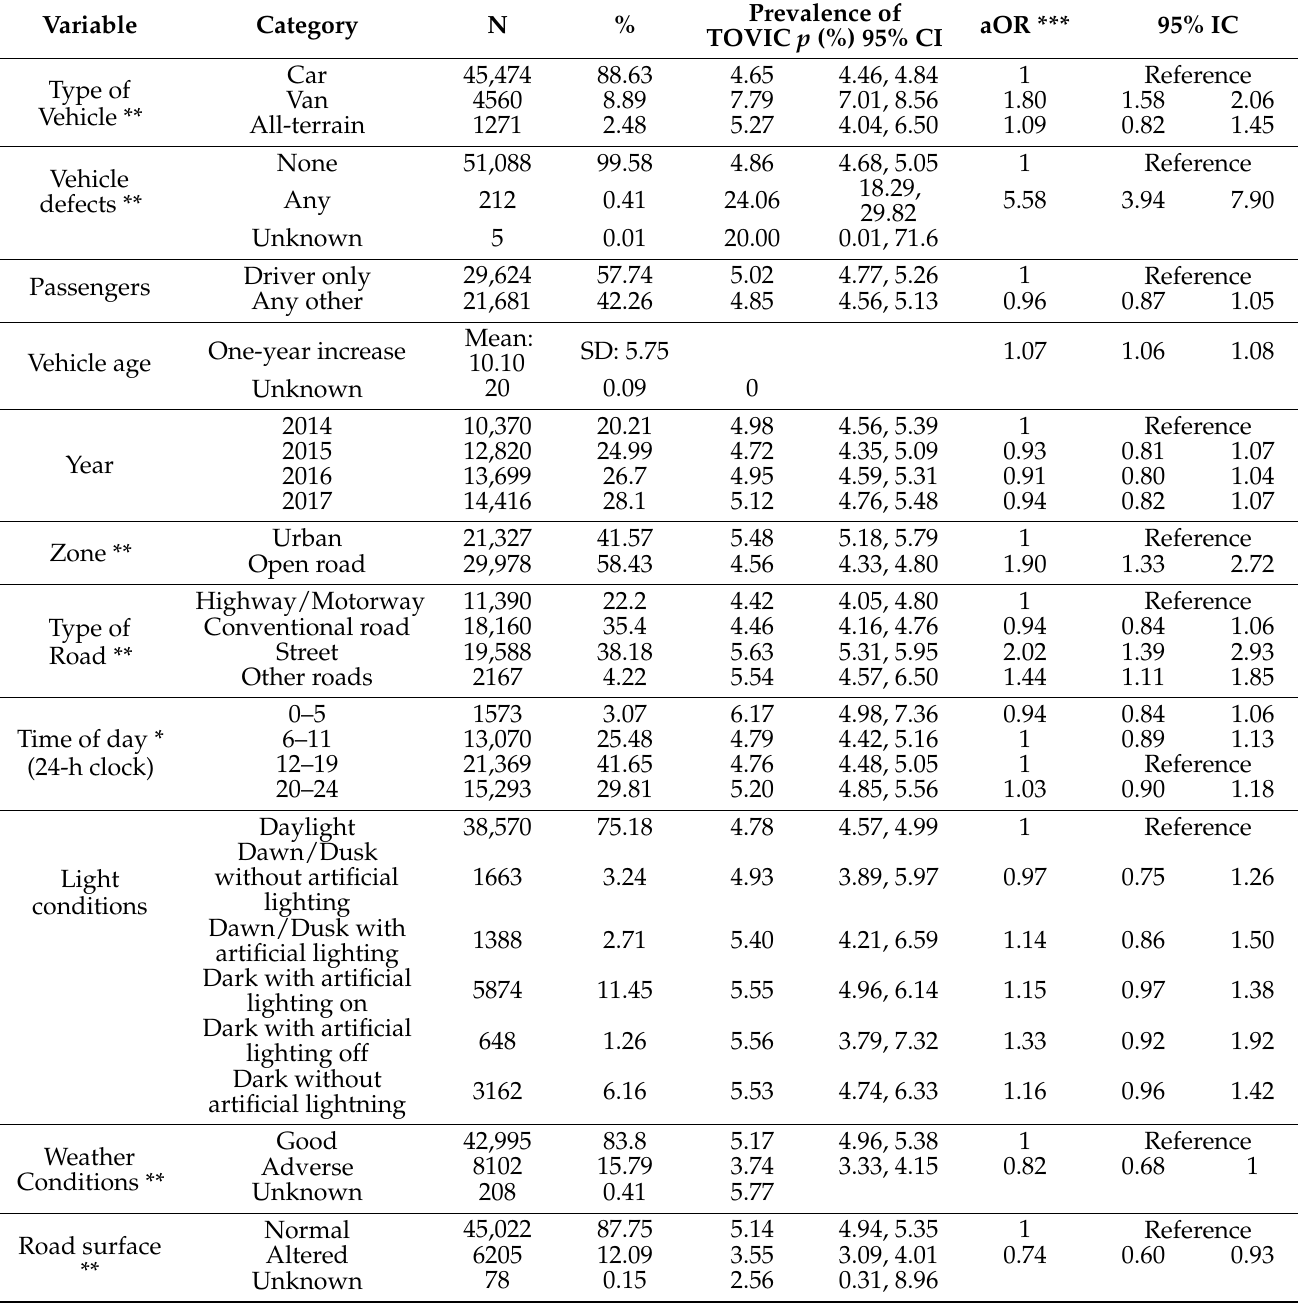
Table 2. Distribution of variables in the sample, prevalence of TOVIC in each category, and adjusted odds ratios for the association between TOVIC and each category of vehicle- and environmental- related